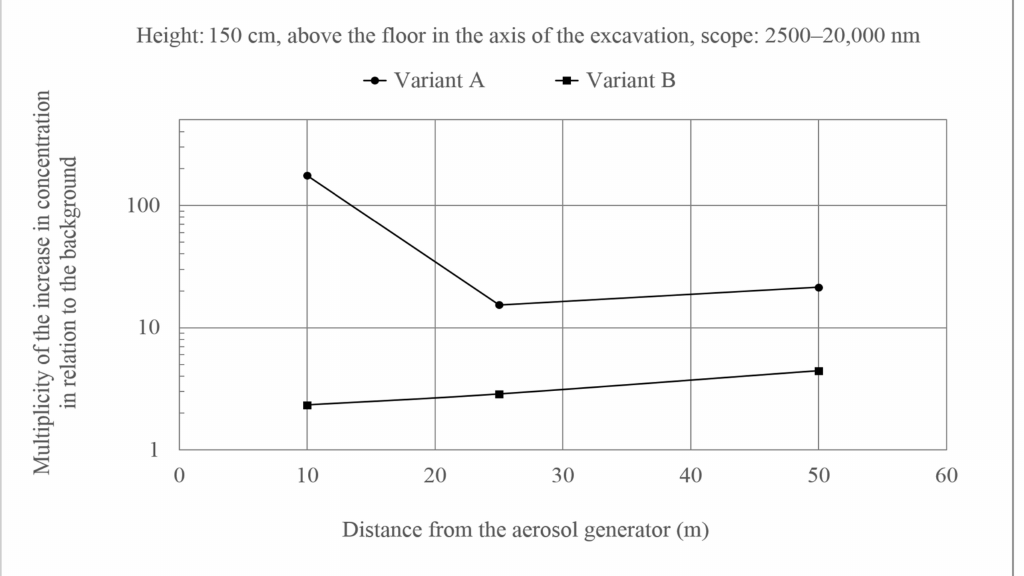
Figure 5. Increase of aerosol concentration of 2500–20,000 nm at the height of 150 cm above the floor in the axis of the excavation in relation to the background. Generator capacity: 17 cm 3 of